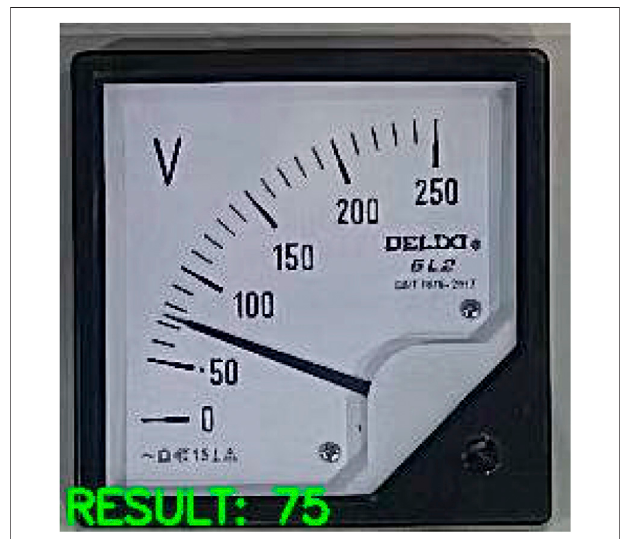
FIGURE 8 | The reading result which exceeds the accuracy of a scale value. It could have read 70 or 80 V, but reading results showed that the voltage was 75 V